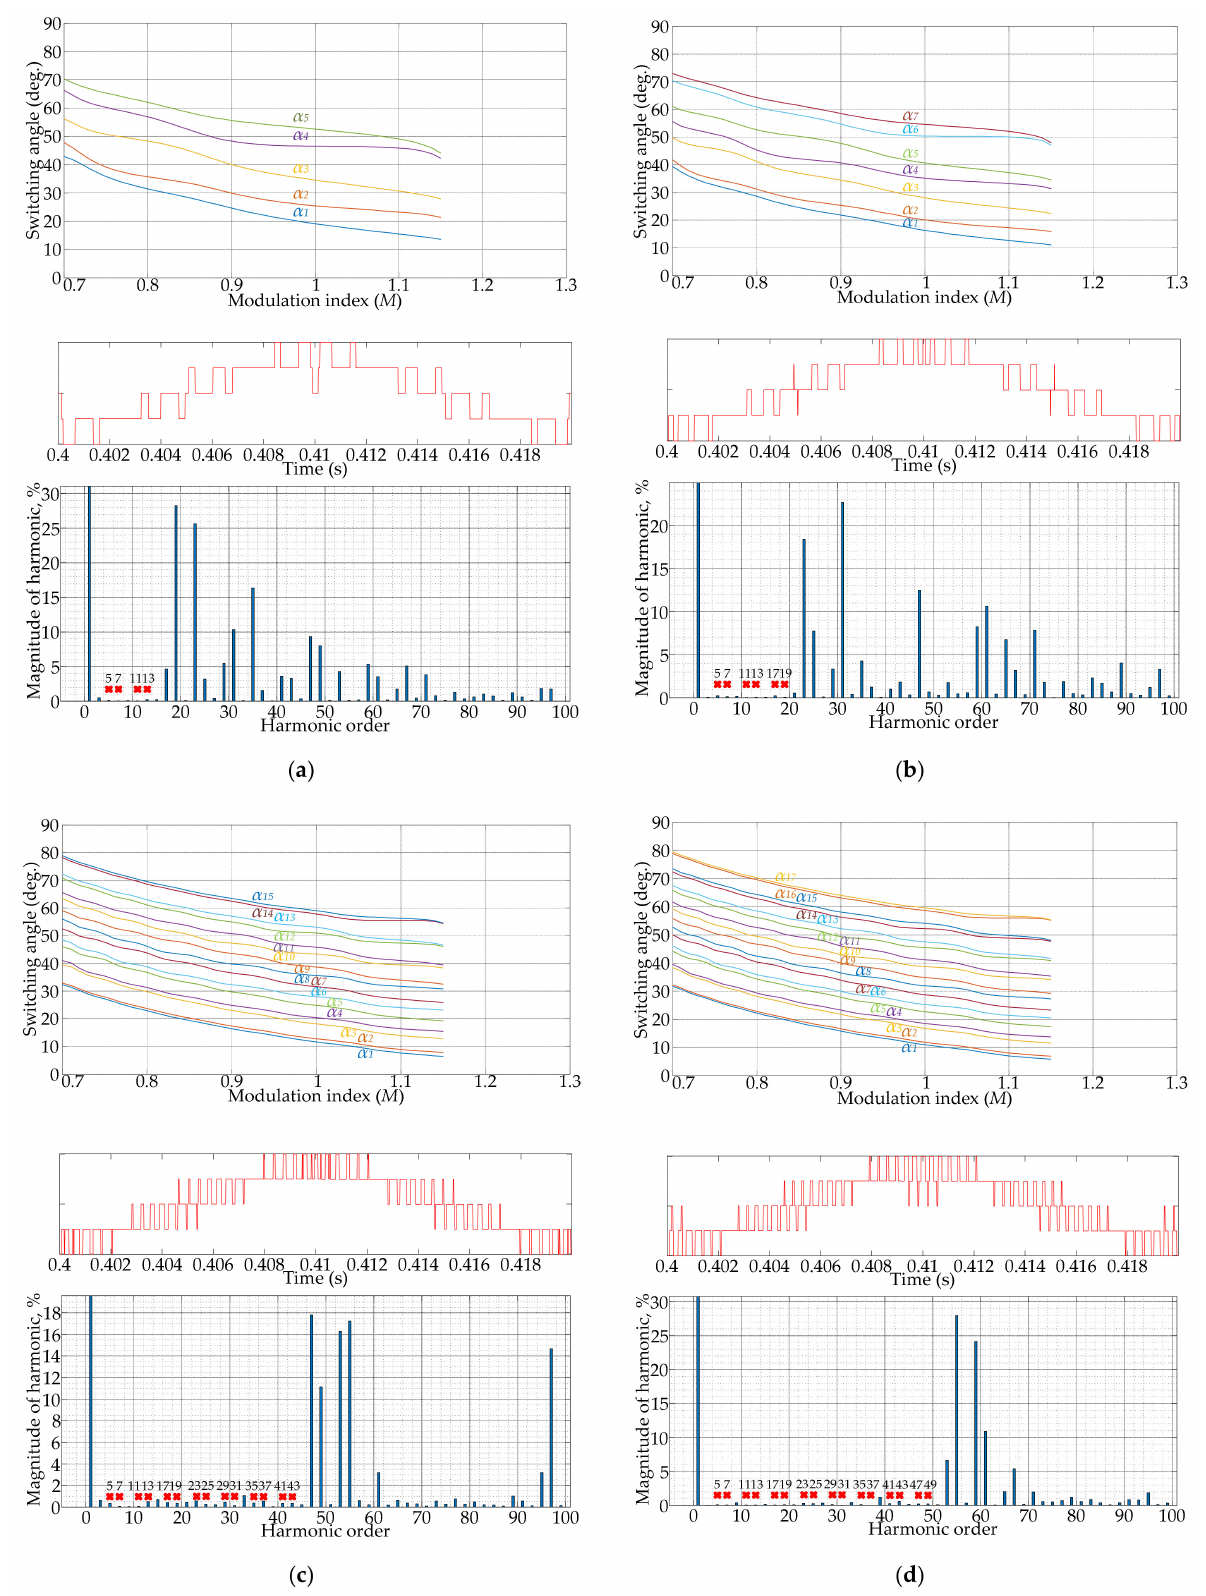
Figure 8. Results of solution trajectories, PPWM waveforms and FFT spectra for six-pulse connection scheme based on fsolve function: ( a ) SHE problem with five switching angles; ( b ) SHE problem with seven switching angles; ( c ) SHE problem with fifteen switching angles; and ( d ) SHE problem with seventeen switching